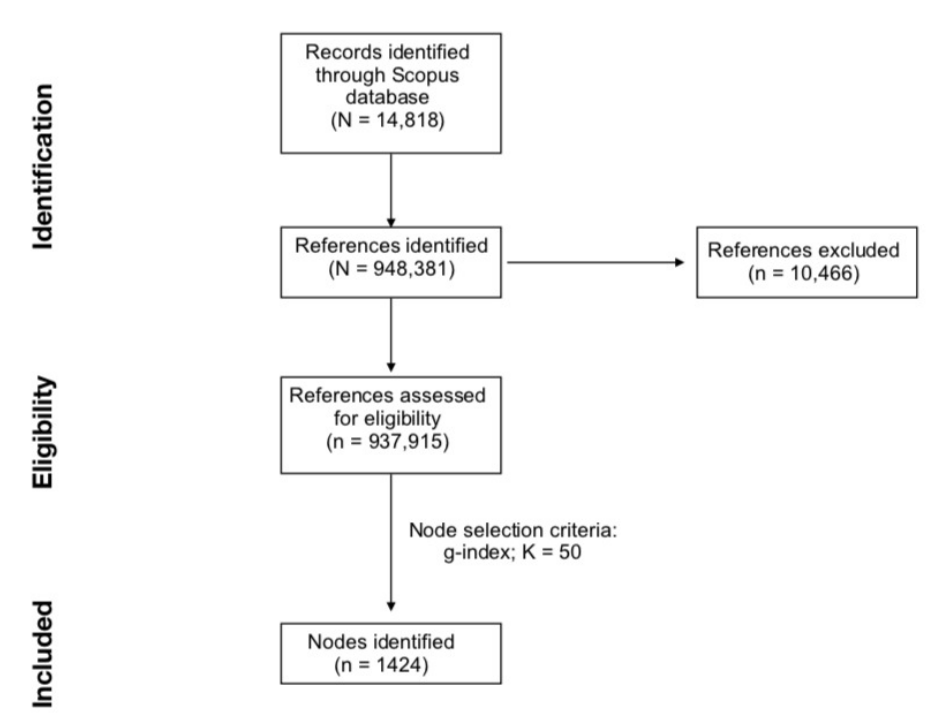
Figure 1. Study flow diagram (adapted from